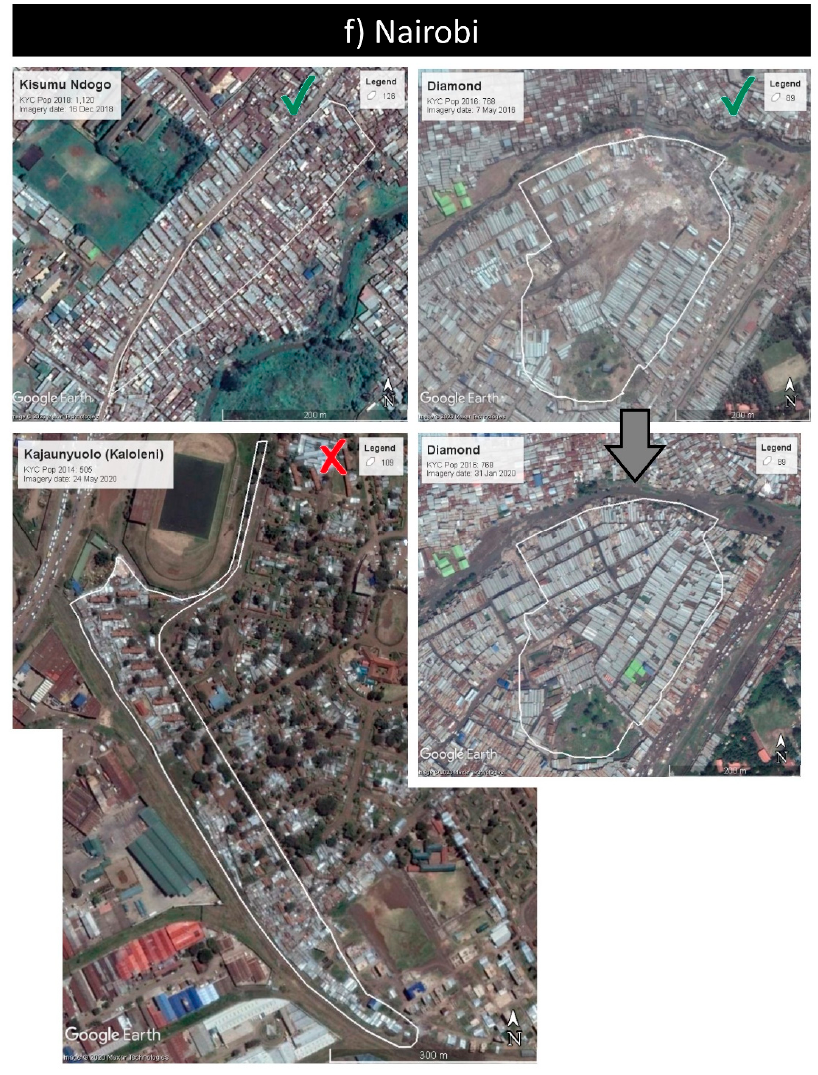
Figure A3. Visuals of the largest KYC reported populations in ( a ) Lagos, ( b ) Port Harcourt, and ( c ) Nairobi, and settlements with larger median gridded population estimates than KYC populations in ( d ) Lagos, and ( e , f ) Nairobi.